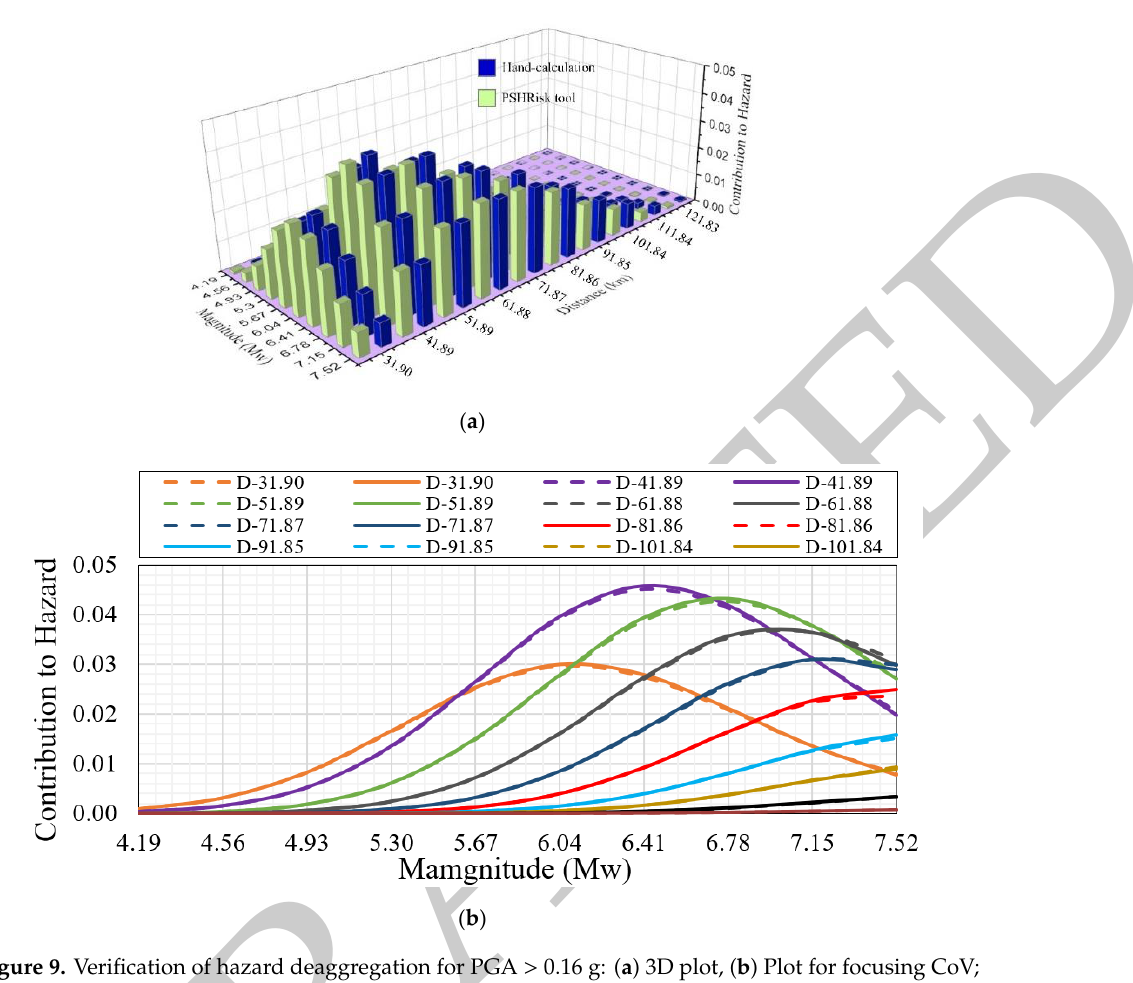
Figure 9. Verification of hazard deaggregation for PGA > 0.16 g: ( a ) 3D plot, ( b ) Plot for focusing CoV; D = Distance (km).